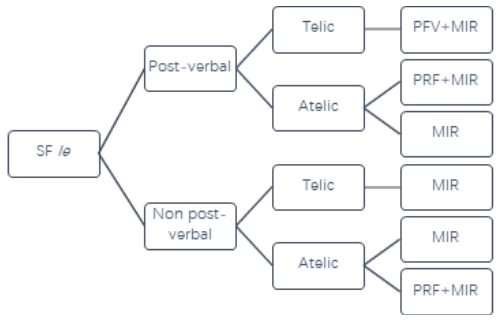
Figure 1. The functions of le at the sentence-final